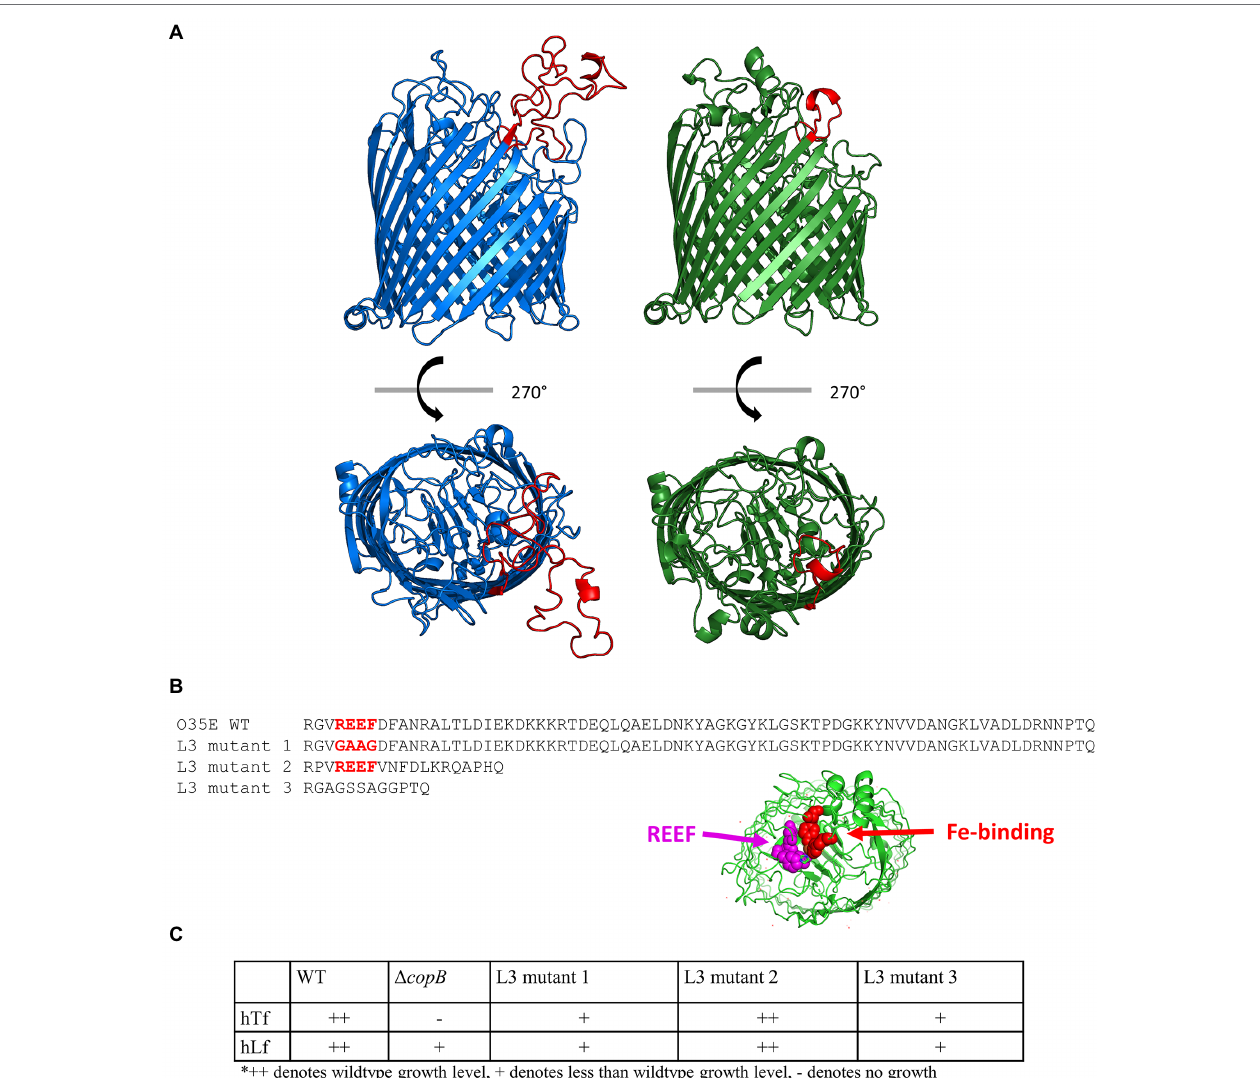
FIGURE 7 | Role of REEF domain in loop 3. (A) Homology models of CopB from M. catarrhalis strain O35E (blue) and strain 417:082 (green). Extracellular loop 3 is shown in red. (B) Sequences of extracellular loop 3 from O35E WT, L3 mutant 1, L3 mutant 2, and L3 mutant 3. Location of REEF and Fe-binding residues. (C) hTf, hLf, and pTf growth phenotypes of CopB loop 3